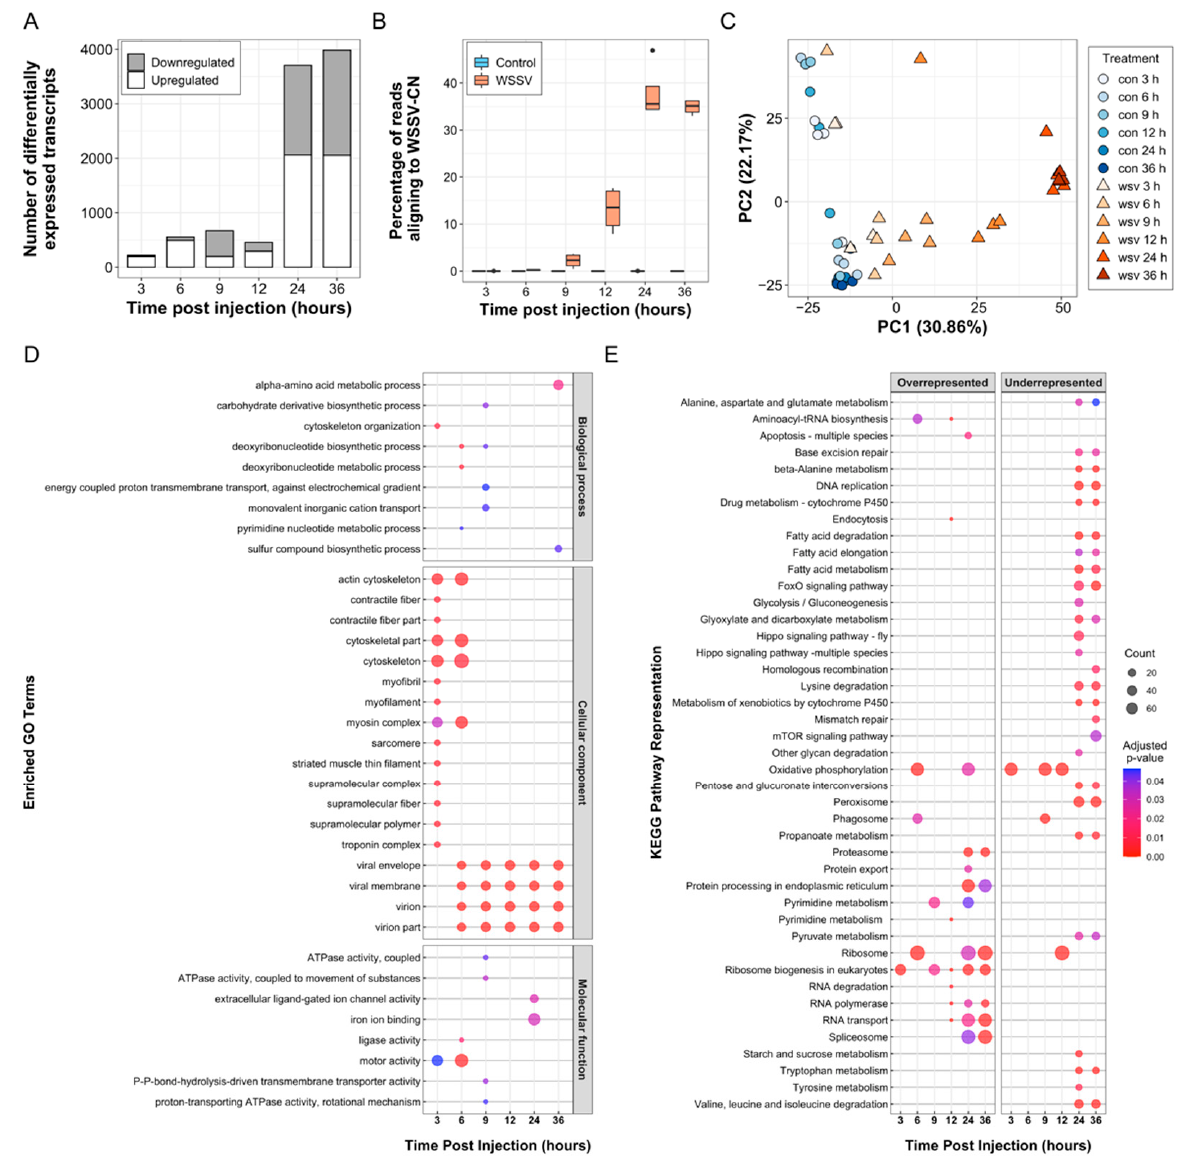
Figure 3. Transcriptome analysis. ( A ) A stacked bar plot depicting the number of significantly upregulated and downregulated transcripts over time following WSSV injection. ( B ) Boxplot illustrating the percentage of trimmed sequencing reads from control and WSSV-injected shrimp aligning to the WSSV-CN genome (GenBank Accession: AF332093.3 [61]) over time. ( C ) Principal component analysis demonstrating similarity between the differentially expressed transcripts in each treatment and timepoint according to principal component 1 (PC1) and principal component 2 (PC2). ( D ) Temporal enrichment of gene ontology (GO) terms within the lists of differentially expressed transcripts at each timepoint following WSSV injection. The size of each point indicates the number of transcripts assigned to each GO term, and the colour indicates the adjusted p -value associated with the GO term’s enrichment. ( E ) Over- and underrepresented KEGG pathways within the expressed transcripts at each timepoint following WSSV injection. Point size indicates the number of transcripts present within each KEGG pathway, and the colour indicates the adjusted p -value associated with the KEGG pathway’s